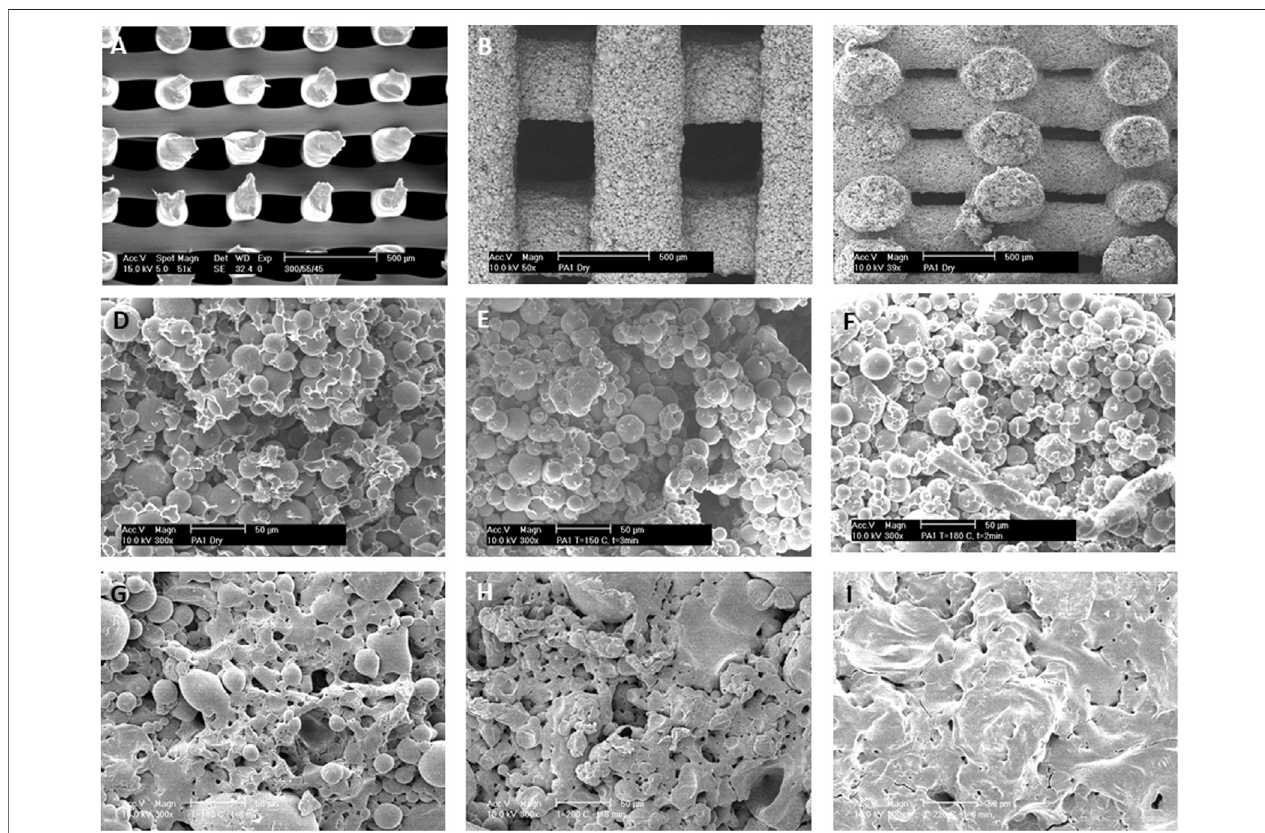
FIGURE 2 | 3D deposited scaffolds fabricated by (A) melting extrusion of 300PEOT55PBT45 thermoplastic polymers or (B – F) extrusion of 300PEOT55PBT45- PVP microspheres polymeric pastes at room temperature. (B,C) Top and cross section views of fabricated scaffolds from polymeric pastes showing a completely interconnected pore network. (D – F) Microspheres are loosely bound after (D) drying at room temperature or coalesced after “ soft ” sintering at (E) 150 ° C and (F) 180 ° C for 1 minute. (G – I) The effects of sintering temperatures on microsphere coalescence. 300PEOT55PBT45-PVP pastes were sintered for 8 min at (G) 170 ° C, (H) 200 ° C, and (I) 220 ° C. Scale Bar: (A – C) 500 μ m; (D – I) 50